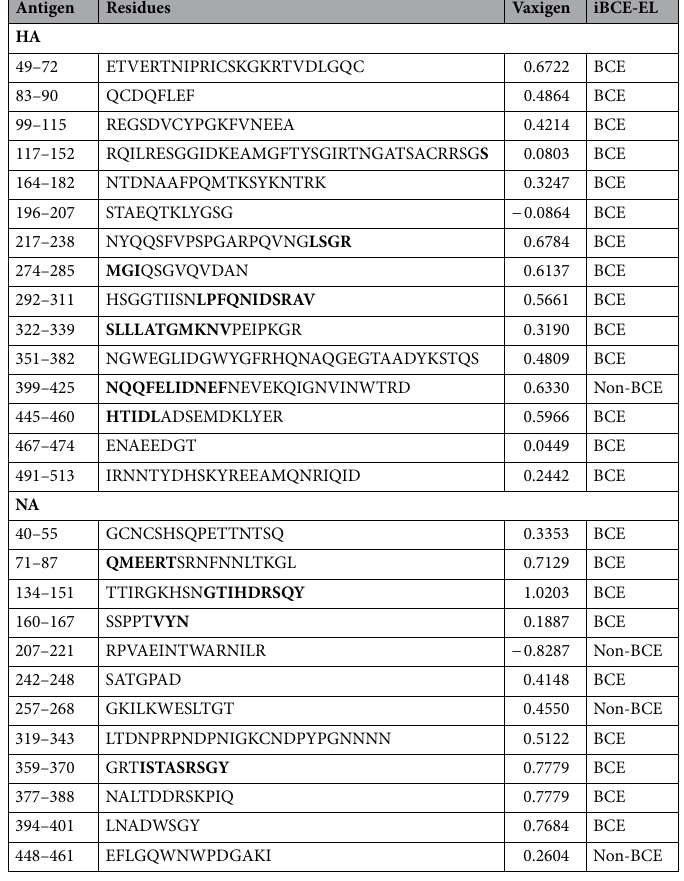
Table 1. Liner B-cell epitopes predicted from HA and NA antigens. Overlapped liner B cell epitopes with conformational B-cell epitopes are shown in bold